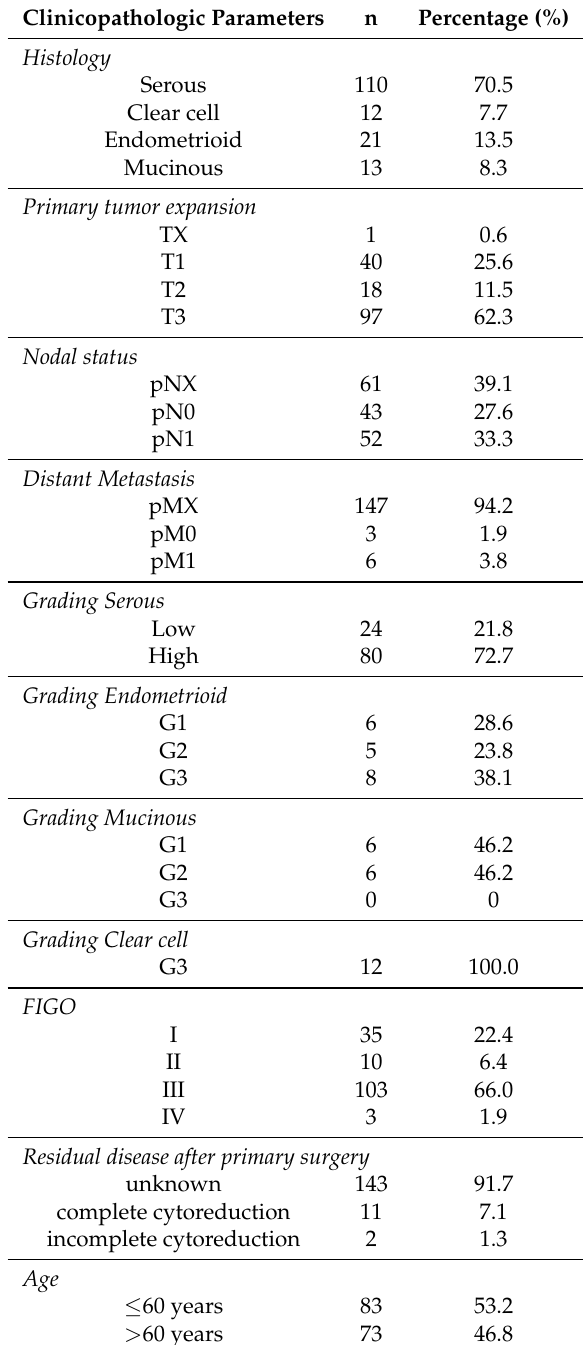
Table 1. Clinicopathologic characteristics of the ovarian cancer